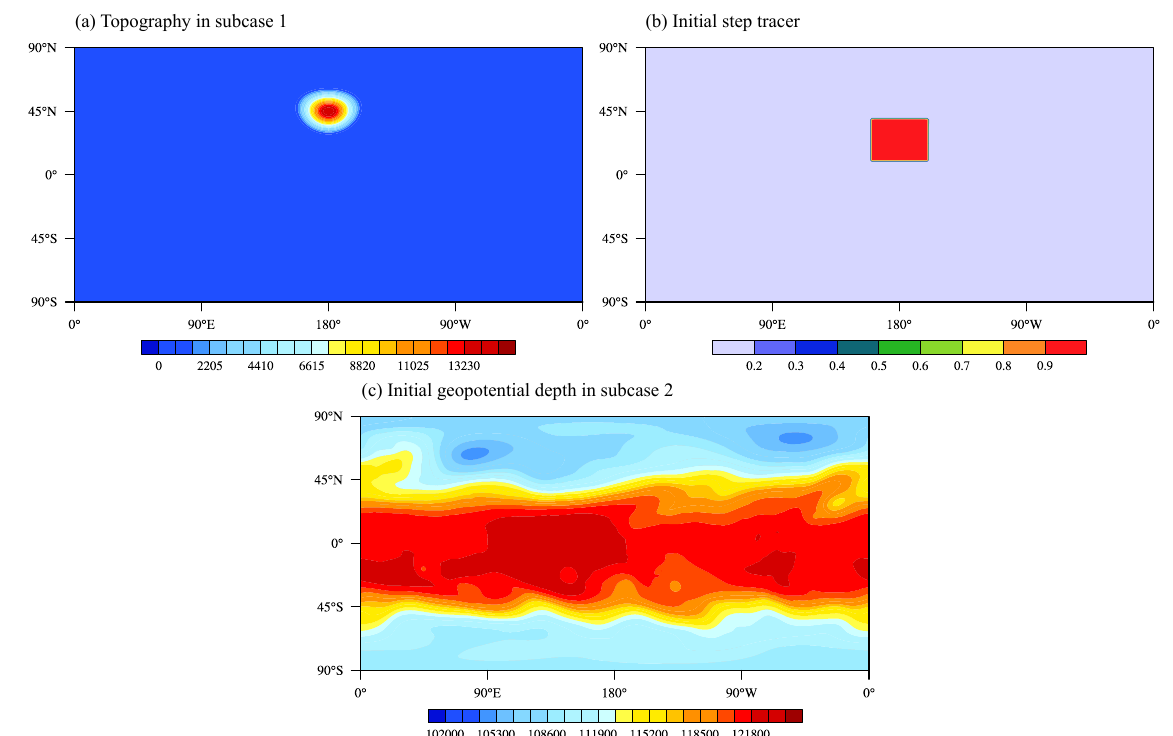
Figure 14. (a) The surface geopotential in subcase 1. (b) The initial step tracer mixing ratio. (c) The initial geopotential depth in subcase 2 (wind field is